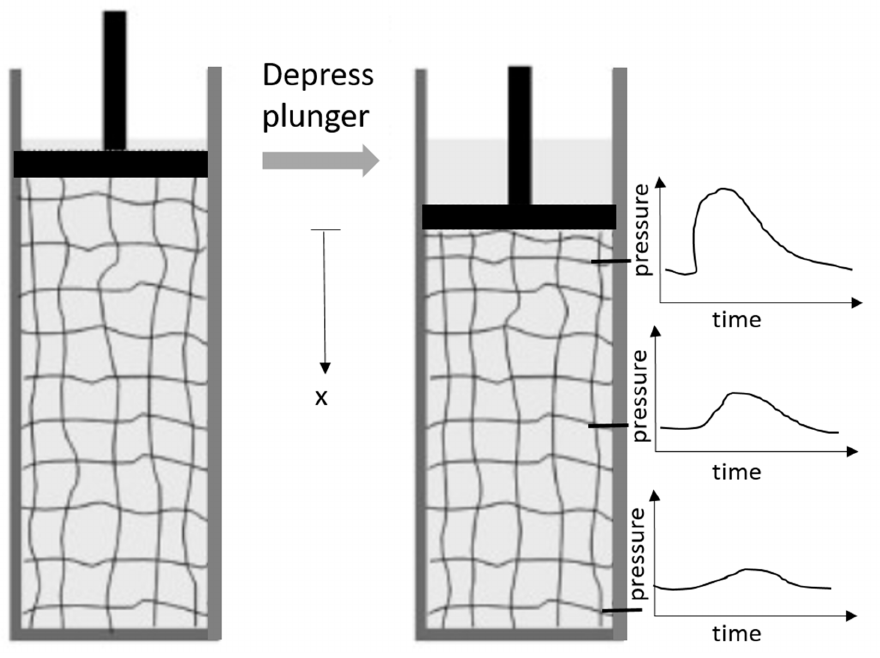
Figure 1. Depiction of the Terzaghi Problem [55].